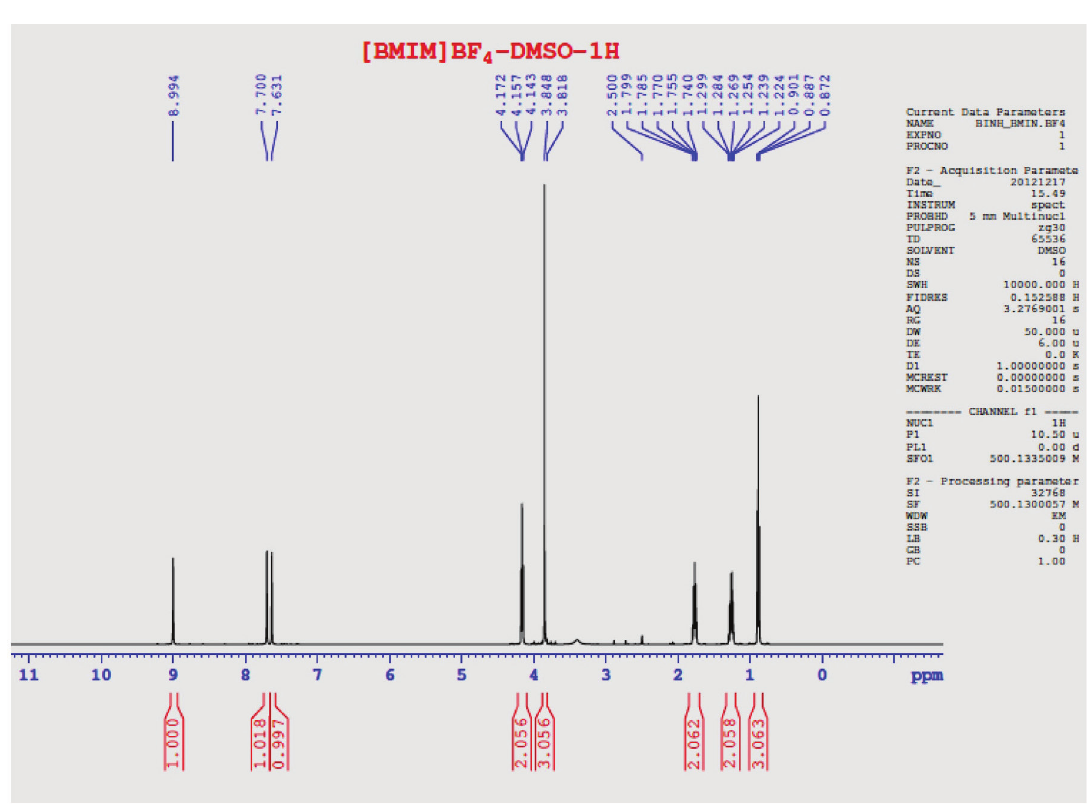
Fig. S4 – FT-IR spectrum of [BMIM][BF